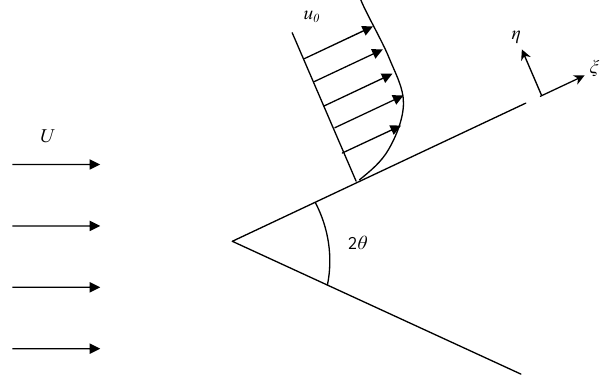
Fig. 1. Laminar boundary layer growth over a wedge of angle 2 θ .